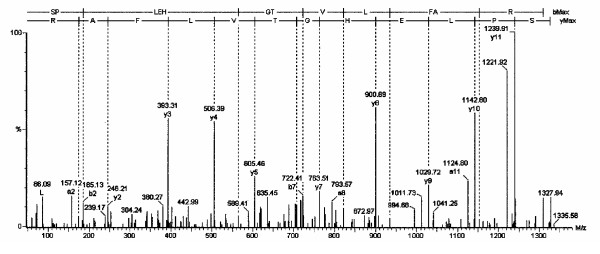
The tandem mass spectrum is shown for the neuroglobin amino acid 19 to 30 peptide.